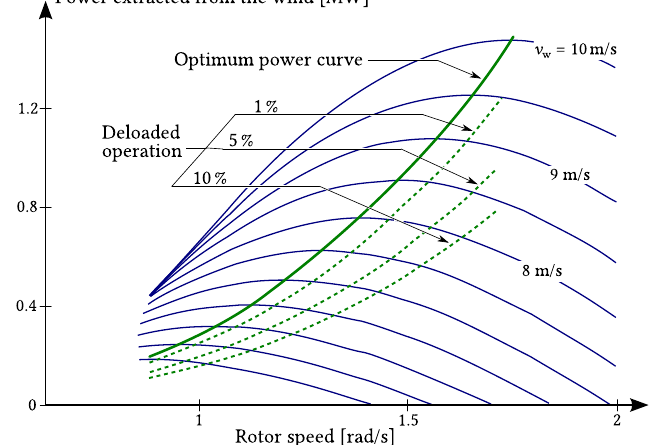
Figure 16. Deloaded operation by means of speed control for a 1.5 MW DFIG-based wind turbine.